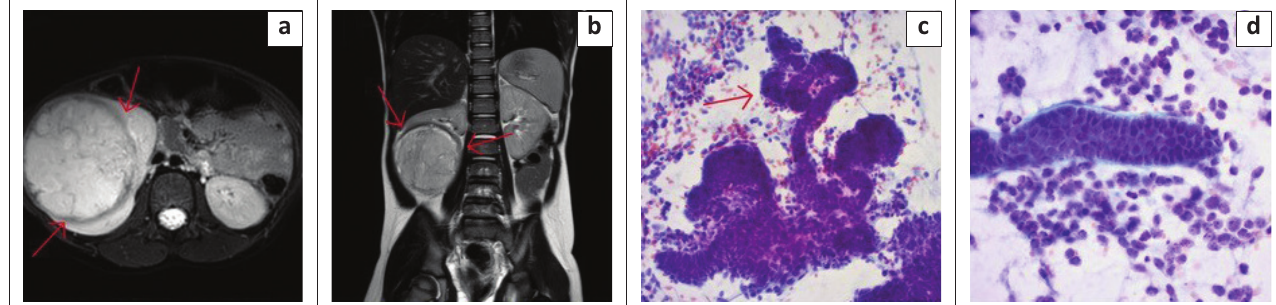
FIGURE 2: (a) Axial T2W and (b) Coronal T2W images demonstrate a large heterogeneously hyperintense mass with sharp angles (red arrows) on either side of the surrounding normal renal parenchyma described as the ‘claw sign’, in keeping with renal origin. (c) Shows cytological image of blastema cells dispersed with tubule formation (red arrow). The tubules are more rigid and seem to form a tubular structure (Papanicolaou stain 20×). (d) Higher magnification shows a tubule with surrounding basement membrane material (greenish in colour) (Papanicolaou stain 40×).